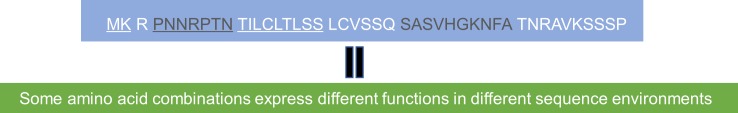
An amino acid sequence can be considered a sentence.